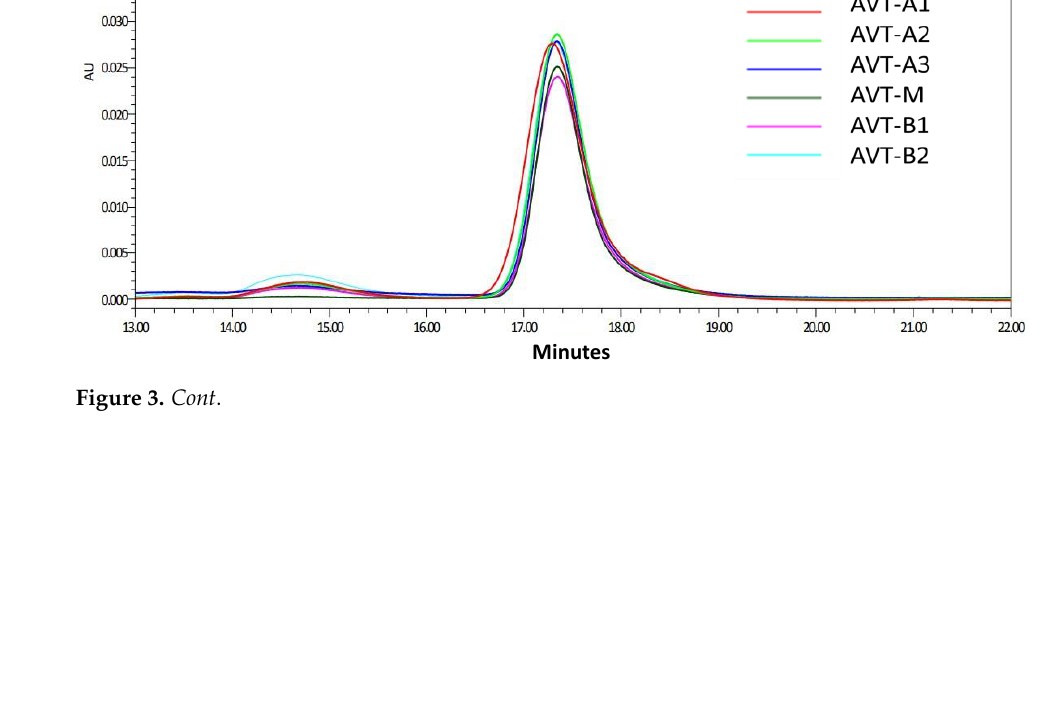
Figure 3. SEC-HPLC analysis results of each fraction. ( A ) Overlay chromatograms of AVT08 charge variant fractions. ( B ) Overlay chromatograms of SIMAB054 charge variant fractions. 3.2. Intact Protein Analysis of Fractionated Charge Variants The chemical characterization of the charge variant fractions was initially performed by intact protein analysis using mass spectrometry. Intact protein analysis is one of the most critical structural elucidation tools for mAbs. The intact mAb analysis reveals the exact molecular weight of the sample. The method also helps to define the modifications that cause a significant molecular weight shift (>100 kDa), such as glycosylations (>1200 Da) and C-terminal lysine clippings (128 Da) [56]. As one of the best-studied modifica- tions, glycosylation is found in the highly conserved Asn303 residue in each heavy chain of Avastin ® [57], and its potential correlation with charge heterogeneities was previously reported [58]. It is already known that the major N-linked glycoform of Avastin ® is a bian- tennary fucosylated and agalactosylated structure (G0F: G0F) with fully clipped C-termi- nal lysine residues (molecular mass: ~149.2 kDa) [57]. The SIMAB054 showed the same dominant glycoform when analyzed in its initial form, without charge variant fractiona- tion. All charge variant fractions of the AVT and SIMAB054 were analyzed by intact anal- ysis under the same experimental conditions to determine whether there were any glyco- form differences between the charge species. The B5, B6, and B7 basic fractions were pooled together before the analysis to increase the sample concentration. The final sample was labeled as B5 for all remaining analyses.